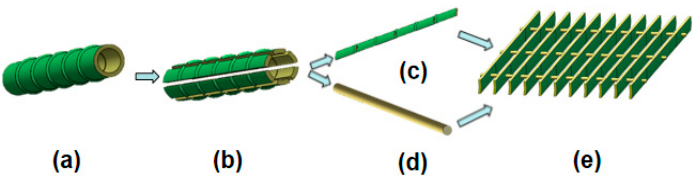
Figure 1. Preparation process of bamboo grid packing (BGP): ( a ) Raw bamboo; ( b ) radial splitting; ( c ) bamboo strip; ( d ) round bamboo stick; ( e ) bamboo grid